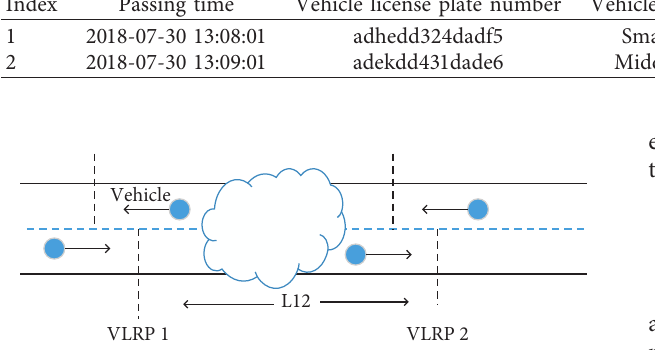
Figure 1: Neighboring VLPRs without an intersection (Case 1).